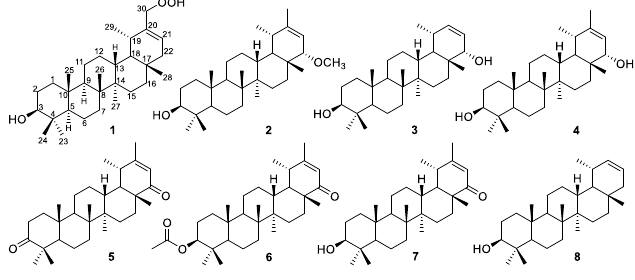
Figure 1. The structures of compounds 1 – 8.